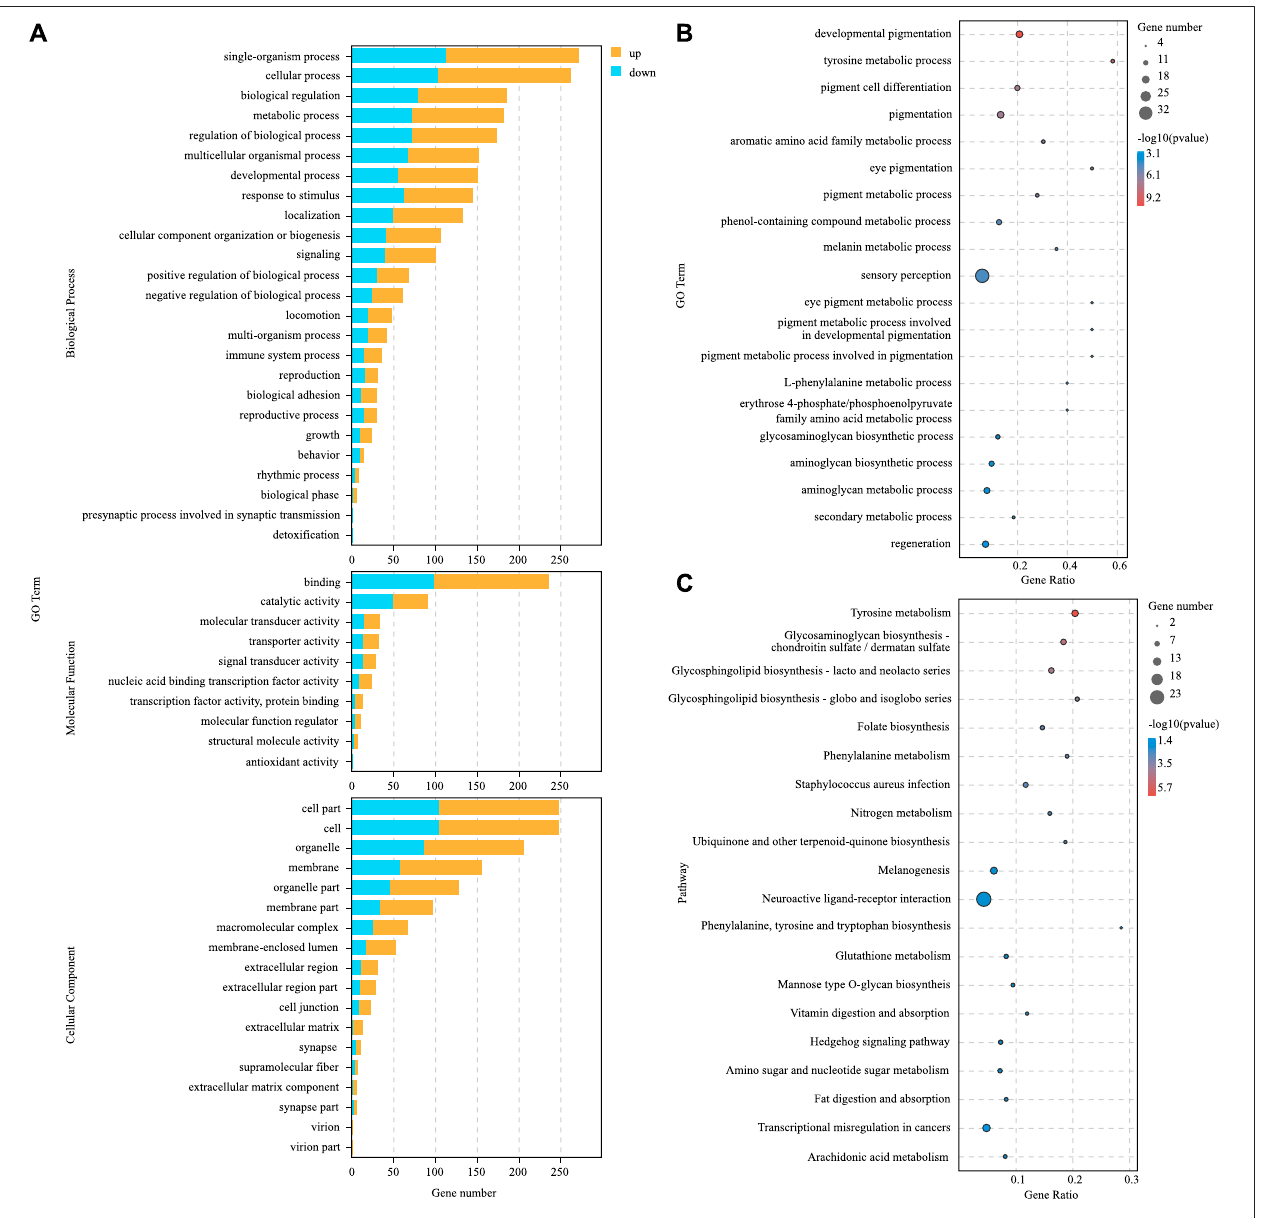
FIGURE 3 | (A) Gene ontology (GO) enrichment analysis results for all DEGs between blind-side normal skin and blind-side hypermelanotic skin. (B) GO analysis resultsinthebiologicalprocessforallDEGsbetweenblind-sidenormalskinandblind-sidehypermelanoticskin. (C) KyotoEncyclopediaofGenesandGenomes(KEGG) pathway enrichment analysis results for all DEGs between blind-side normal skin and blind-side hypermelanotic skin.